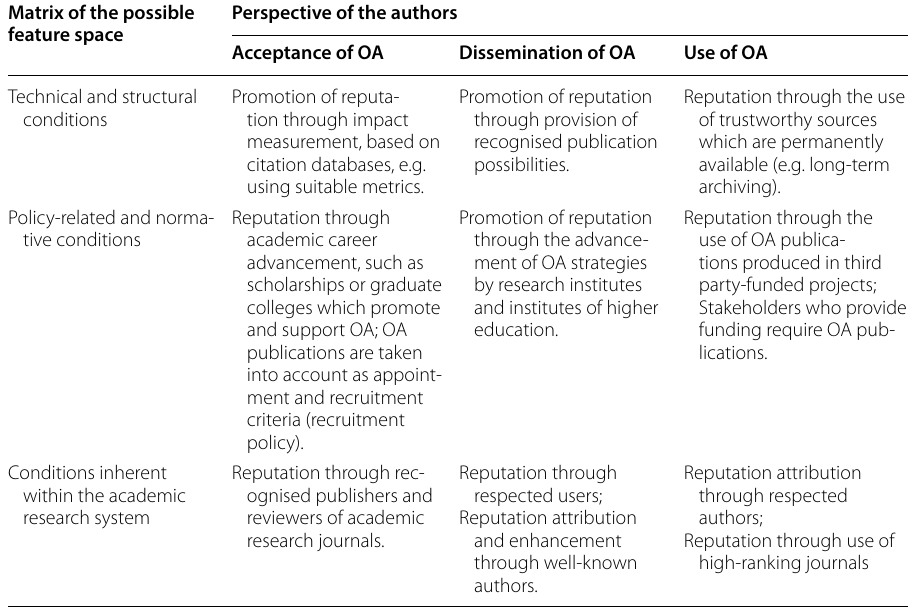
Table 8 RLTW Matrix on the aspect of reputation of authors (Rep) as a condition for the acceptance, dissemination and use of OA in VET research Matrix of the possible feature